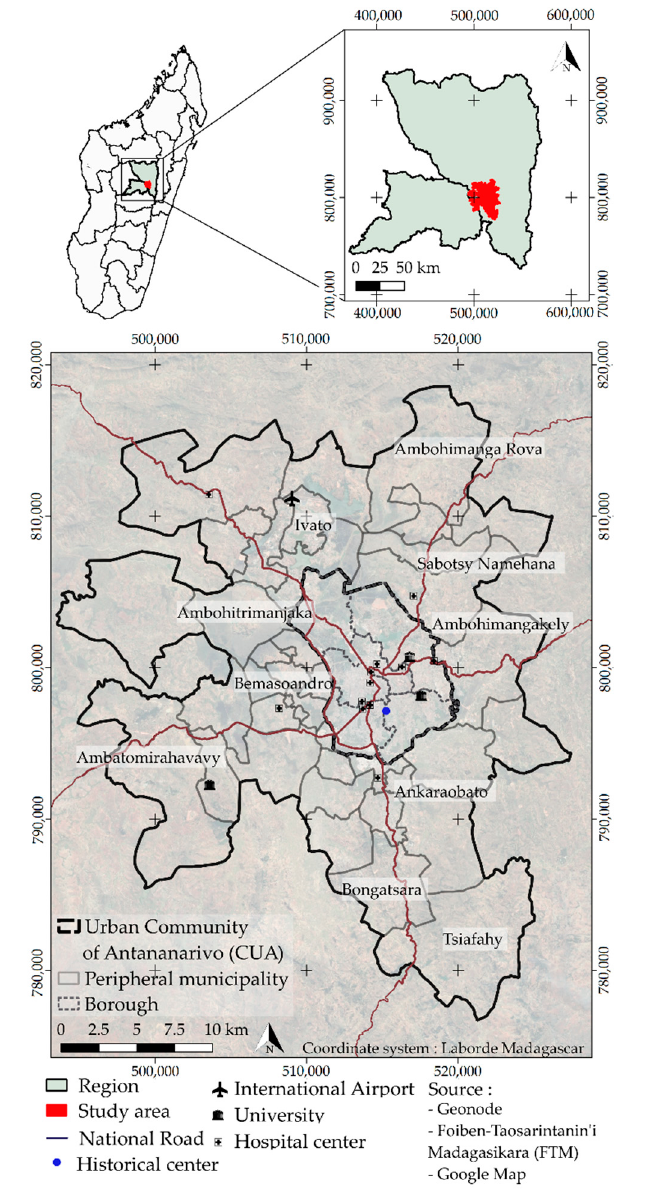
Figure 1. Location of agglomeration of Antananarivo.